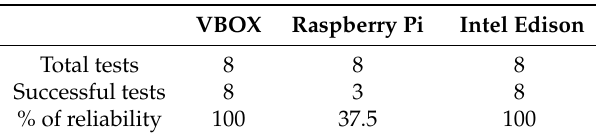
Table 5. Results of reliability.